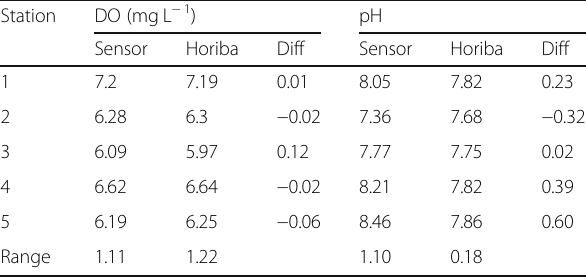
Table 1 Comparison of values taken using the developed prototype and Horiba® probe